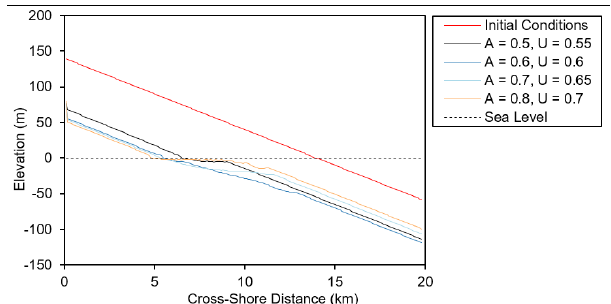
Figure 16. Cross-shore coastal profiles for four simulations where the wave climate is defined by (a) A = 0.5 and U = 0.55, (b) A = 0.6 and U = 0.6, (c) A = 0.7 and U = 0.65, and (d) A = 0.8 and U = 0.7. The initial profile is given as a solid red line, and the water level is given as a dashed black